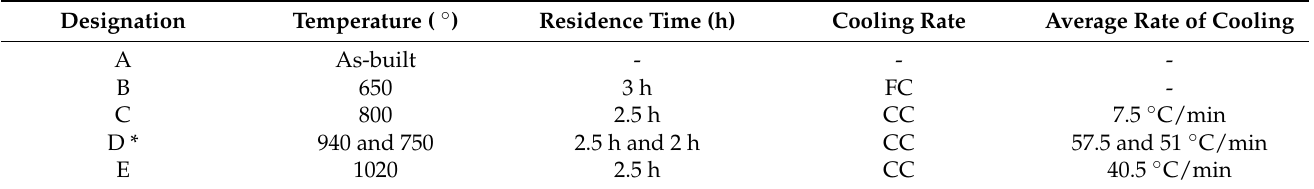
Table 1. The heat treatment strategies and designations of LPBF Ti6Al4V(ELI)